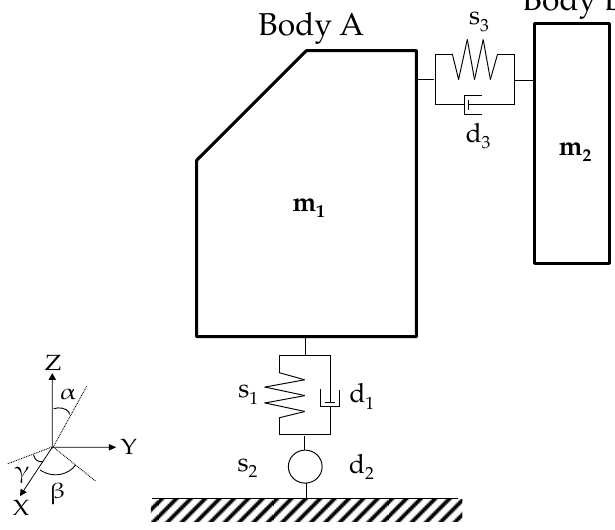
Figure 2. General machine kinematic model.